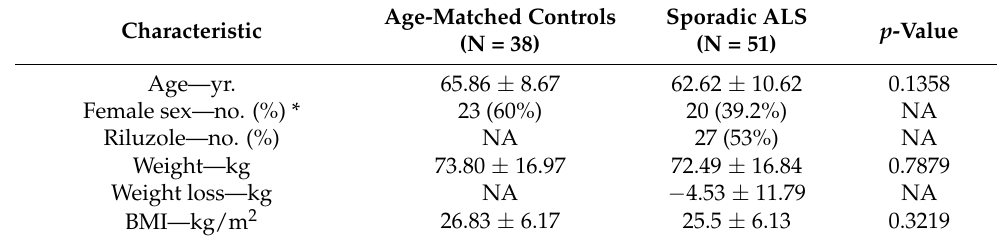
Table 1. Demographics and disease characteristics of ALS patients and controls. Age-Matched Characteristic